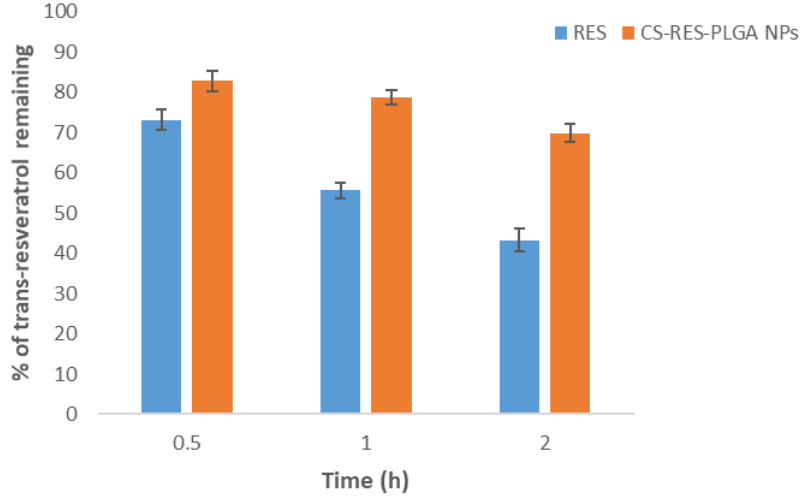
Figure 6. Photostability data obtained for RES and CS-RES-PLGA NPs.